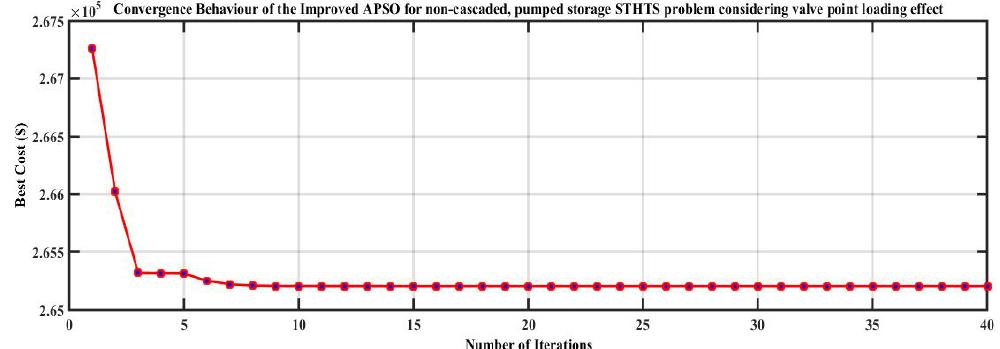
Figure 10. Convergence characteristics of the improved APSO algorithm on the non-cascaded pumped-storage STHTS problem considering valve point